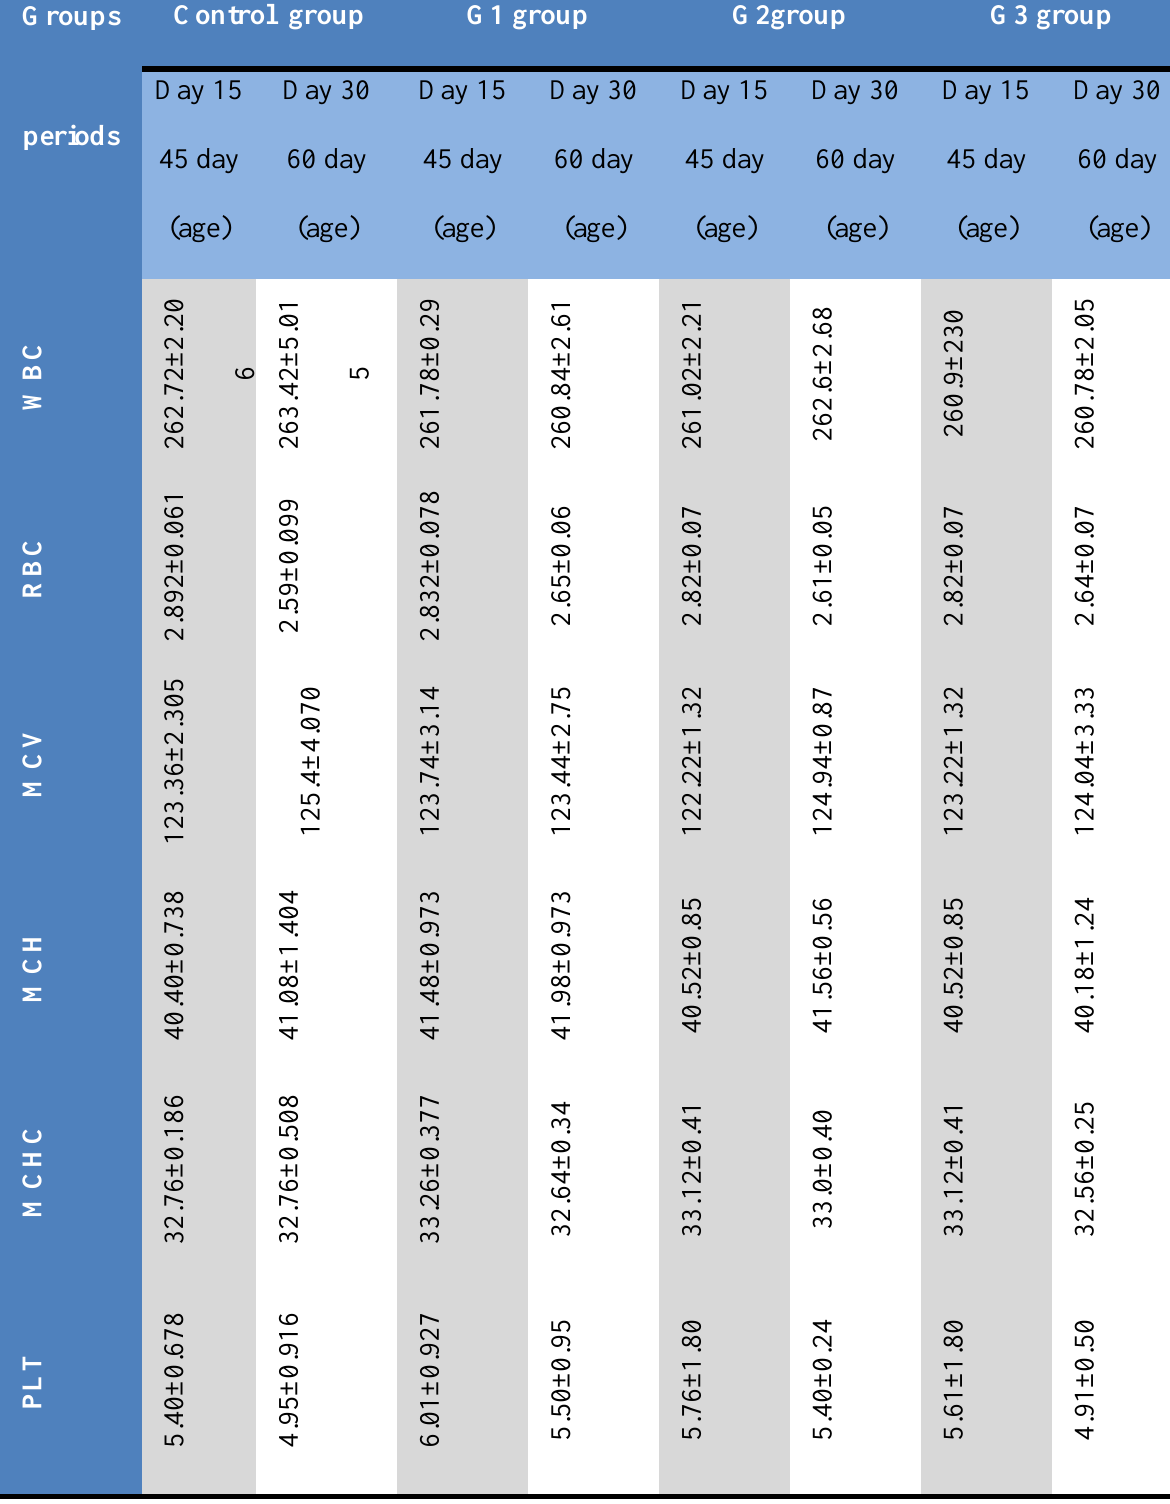
Table 2: Effect of varying doses of estradiol benzoate on the blood picture in